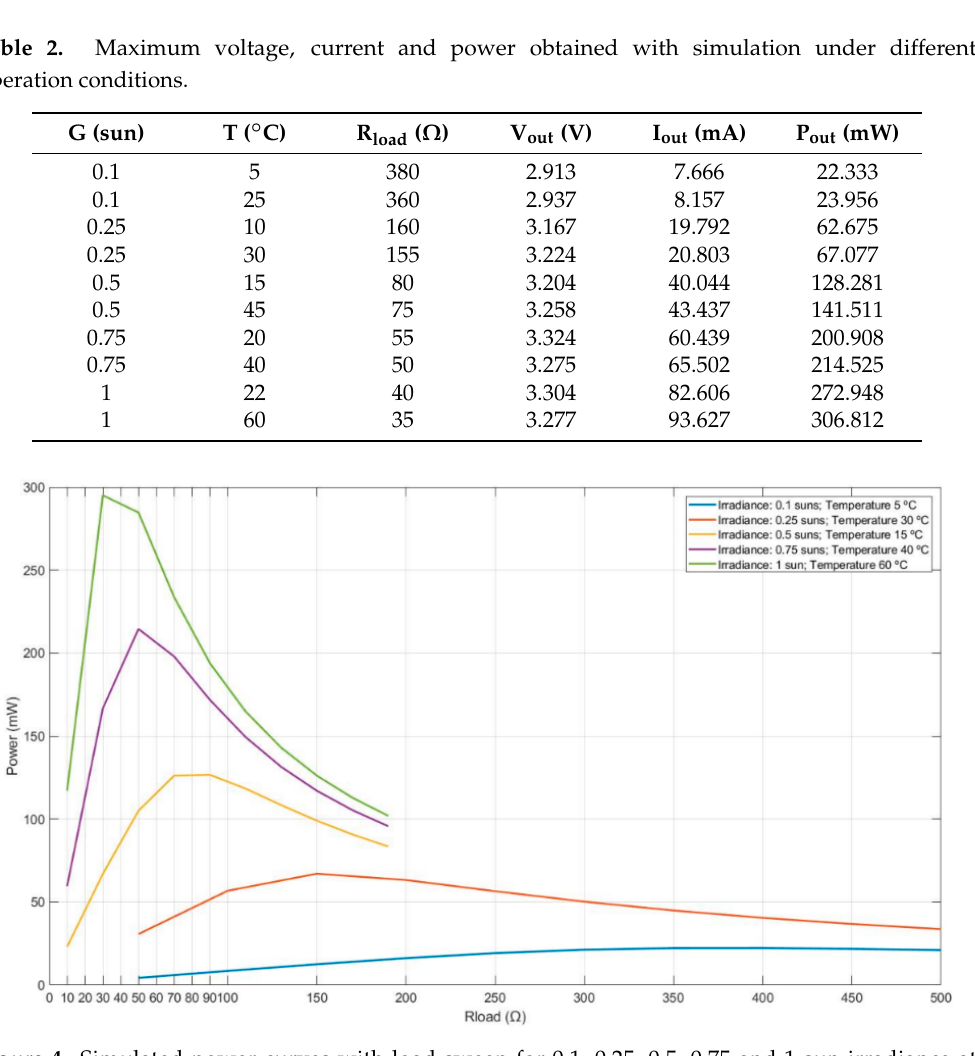
Figure 4. Simulated power curves with load sweep for 0.1, 0.25, 0.5, 0.75 and 1 sun irradiance at different temperatures.